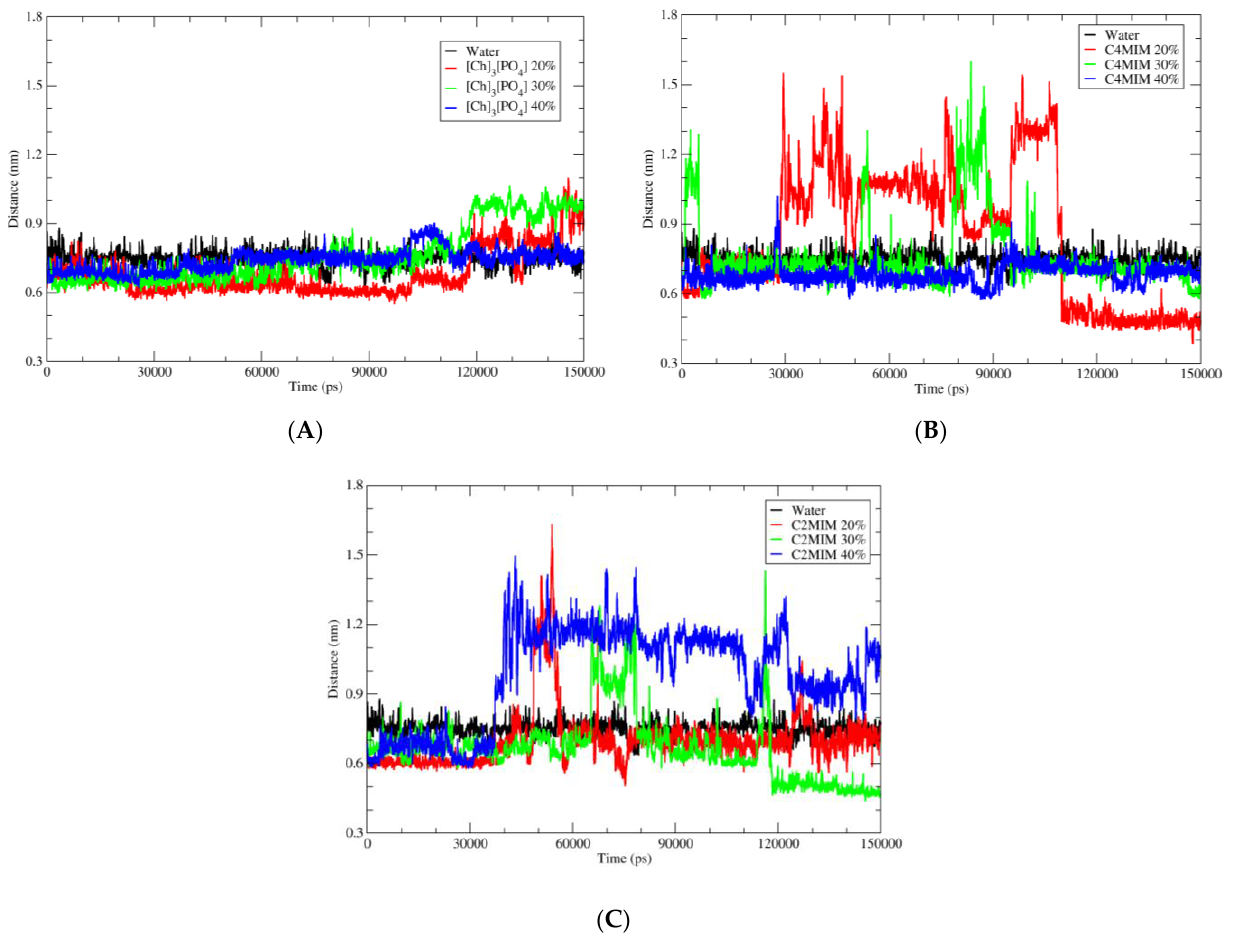
Figure 7. Distance between the C of carbonyl group of BHET with the O of Ser-131 in water and different ionic liquids solutions. ( A ) Pure water in black; 20% of [Ch] 3 [PO 4 ] in red; 30% of [Ch] 3 [PO 4 ] in green and 40% of [Ch] 3 [PO 4 ] in blue. ( B ) Pure water in black; 20% of [C4MIM][Ac] in red; 30% of [C4MIM][Ac] in green and 40% of [C4MIM][Ac] in blue. ( C ) Pure water in black; 20% of [C2MIM][Ac] in red; 30% of [C2MIM][Ac] in green and 40% of [C2MIM][Ac] in blue.